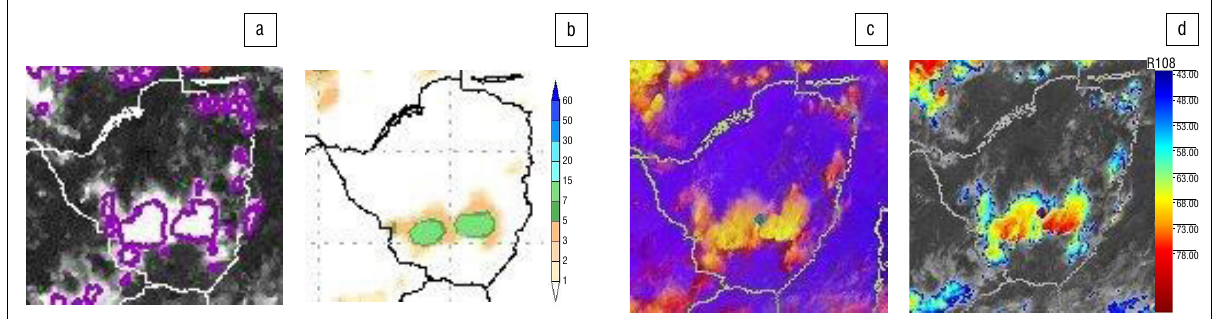
Figure 9: Images for (a) RDT, (b) 3-h TRMM rainfall, (c) convection RGB and (d) IR 10.8 colour-enhanced imagery on 28 December 2013 at 12:00 UTC over the central parts of